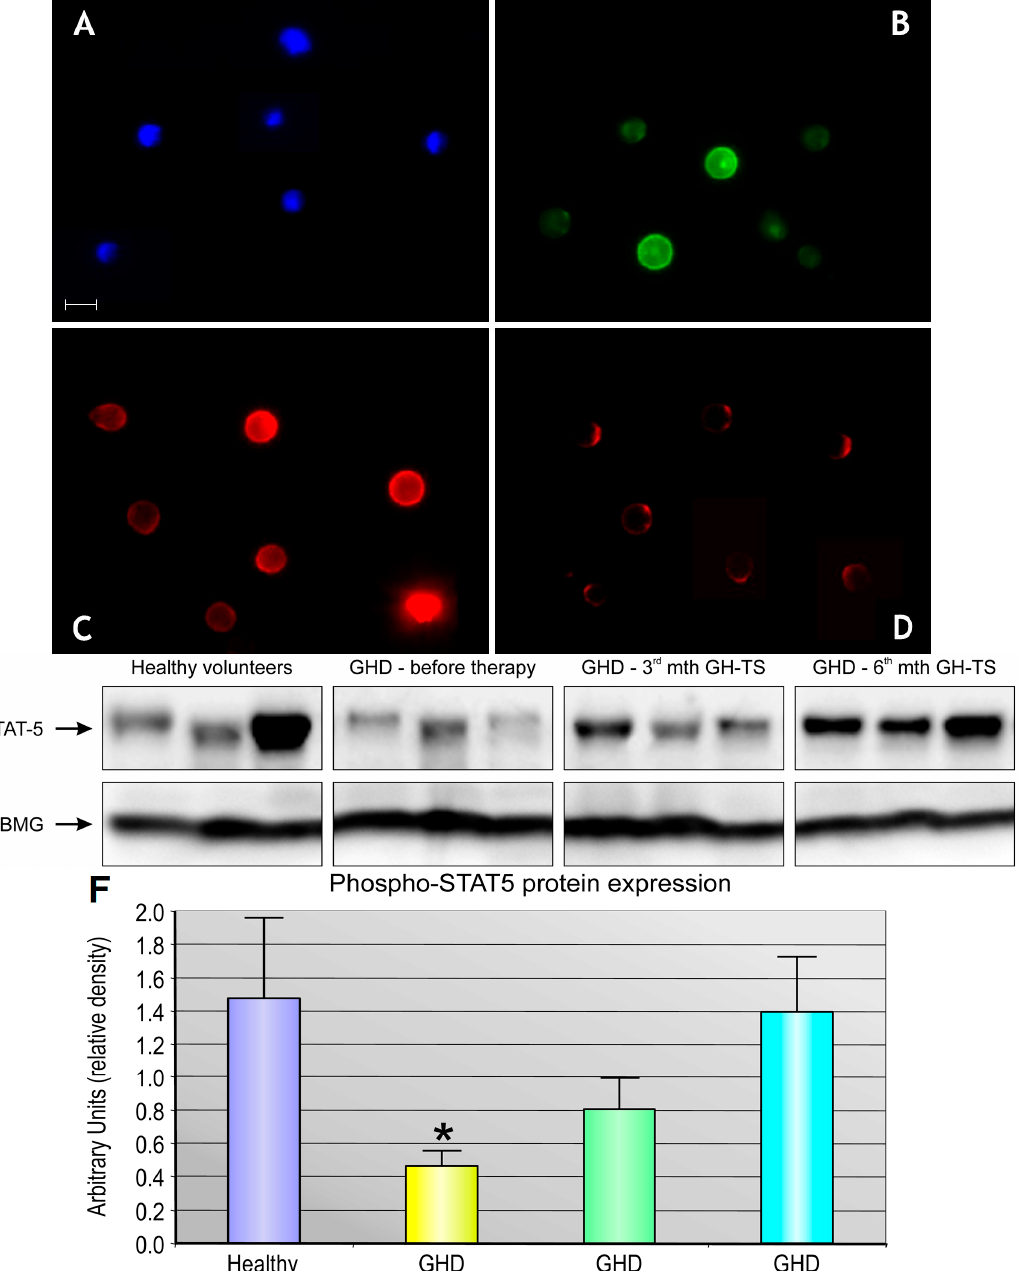
Figure 1. GHR expression in CD34+ cells from GHD patients. The expression of GHR was assessed by immunocytofluorescence in CD34+ cells stained with monoclonal anti-CD45-FITC ( B ) and anti-GHR-PE antibodies ( C , D ); The cell nuclei were stained with DAPI ( A ). Cells were harvested from PB of GHD patients before GH-TS ( A , B , D ) and from their healthy controls ( C ). The expression of each antigen was examined in CD34+ cells of five representative subjects from each group. Representative and selected data are presented. All cells were captured with ×40 objective magnification. Scale bar: 10 µm; The western blot analysis ( E ) and densitometry measurement ( F ) for relative protein quantification of the active, phosphorylated form of STAT-5 (p-STAT) revealed its significantly decreased expression in CD34+ cells from untreated GHD patients and its normal expression in GH-treated GHD patients relative to controls. The band of beta-2-microglobulin (BMG) expression was used as an internal control. Representative and selected data are presented. * p < 0.05.